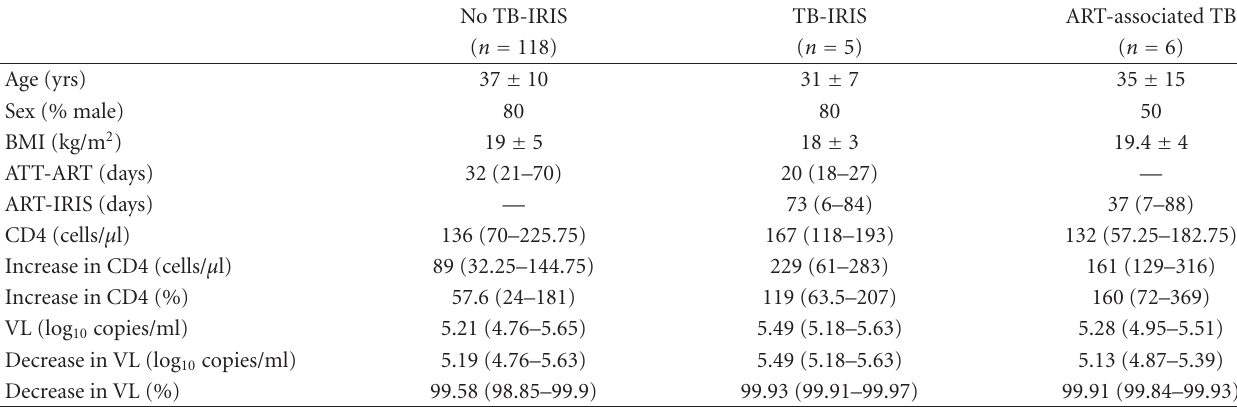
Table 7: Comparison of characteristics between HIV-TB patients without and with TB-IRIS and HIV patients with ART associated TB.